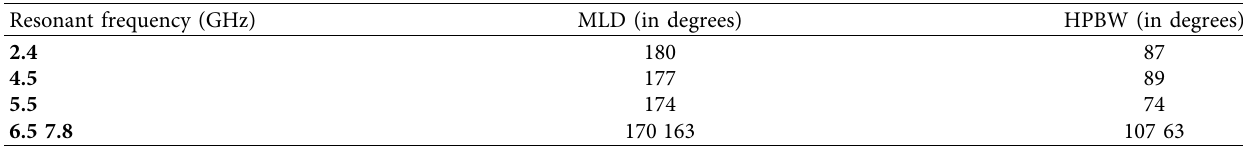
Figure 7: Comparison of measured and simulated 2D radiation patterns. Table 3: HPBW and MLD of E-plane radiation pattern of resonant